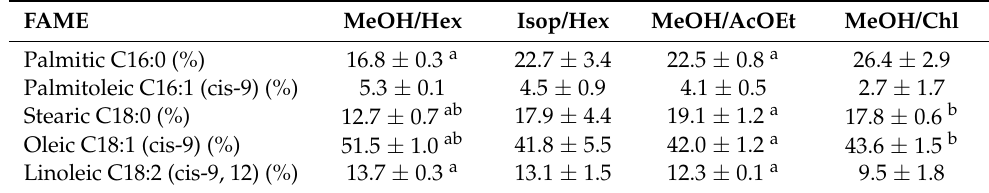
Table 6. Fatty acid (FA) composition of the intracellular lipids of Yarrowia lipolytica , after extraction using different types of organic solvents and transesterification. Number of replicates (N =